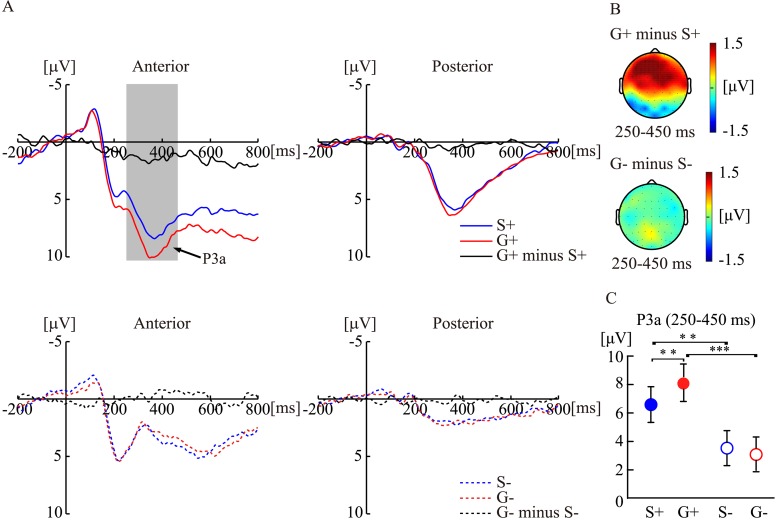
P3a amplitudes to the effect of conclusion specificity in the congruent and incongruent conclusions.A) The grand-averaged waveforms elicited by G+ and S+ arguments and the difference waveforms between G+ and S+ arguments (G+ minus S+) in the anterior and posterior regions; and the grand-averaged waveforms elicited by G− and S− arguments and the difference waveforms between G− and S− arguments (G− minus S−) in the anterior and posterior regions. B) The topographies of the difference waveforms at 250–450-ms time window (G+ minus S+); and the topographies of the difference waveforms at 250–450-ms time window (G− minus S−). C) P3a amplitudes for each kind of arguments. The anterior region indicates the mean amplitudes of F3, F1, Fz, F2, F4, FC3, FC1, FCz, FC2, and FC4 electrodes; the posterior region indicates the mean amplitudes of CP3, CP1, CPz, CP2, CP4, P3, P1, Pz, P2, and P4 electrodes. S+ indicated arguments with specific congruent conclusion categories; G+ indicated arguments with generic congruent conclusion categories; S− indicated arguments with specific incongruent conclusion categories, and G− indicated arguments with generic incongruent conclusion categories.